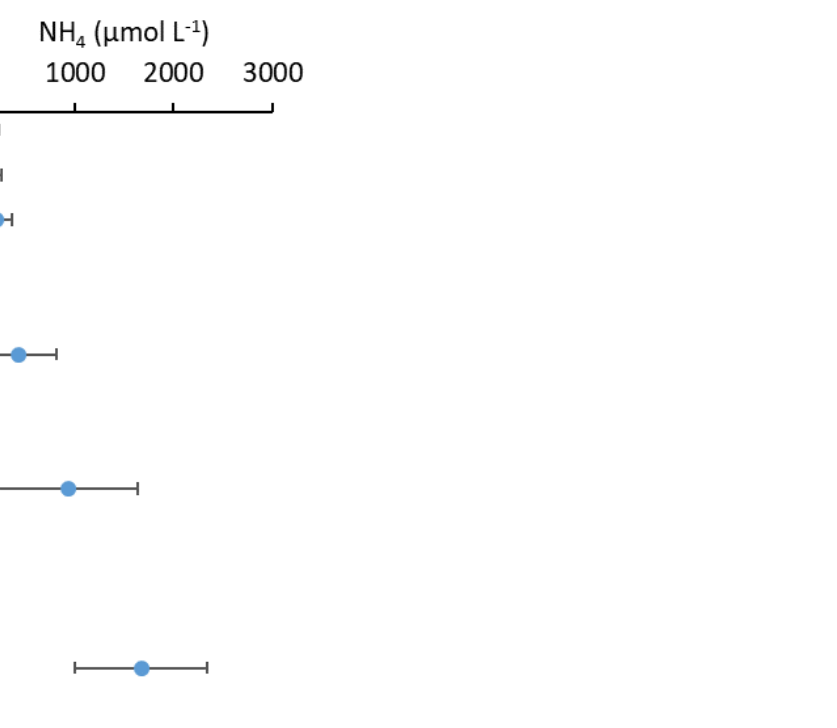
Figure 2. Depth profile of mean (n = 10, ±sd) porewater NH 4 concentrations in Cell 1B, August 2014.